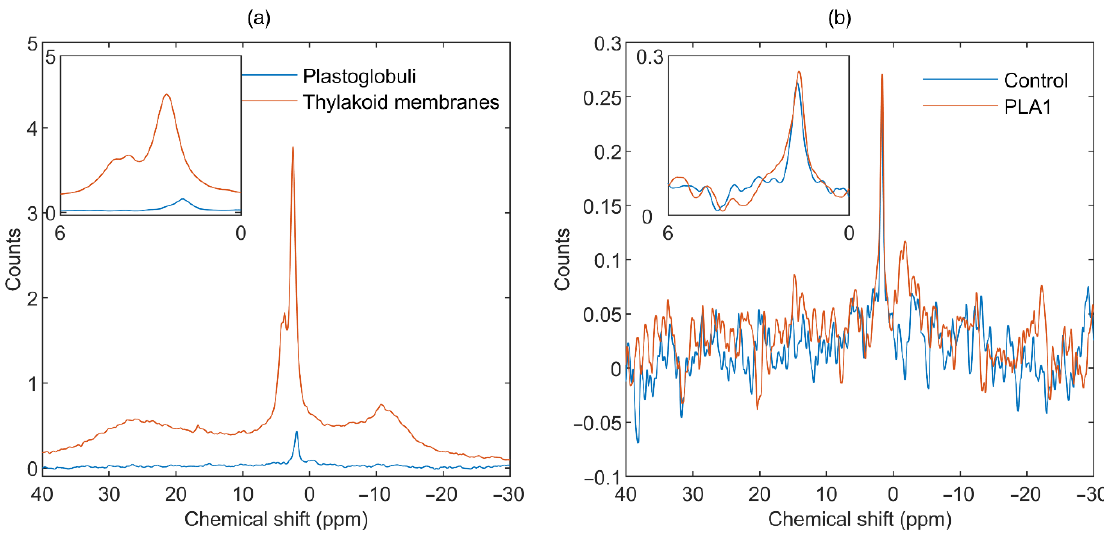
Figure 7. 31 P-NMR spectra of (a) isolated untreated plastoglobuli (blue) and thylakoid membranes (TMs; orange) and (b) untreated plastoglobuli (blue) and plastoglobuli treated for 1 h with 10 U mL − 1 PLA1 (orange). TM spectrum represents an average from 9 independent measurements with 6.25 h of total acquisition time (AT); plastoglobuli spectra were obtained after 1 h of total AT; all spectra were normalized to 1 h AT. Plastoglobuli and TMs were isolated from equal amounts of mature spinach leaves. Inset shows the isotropic region. Temperature, 5 °C.